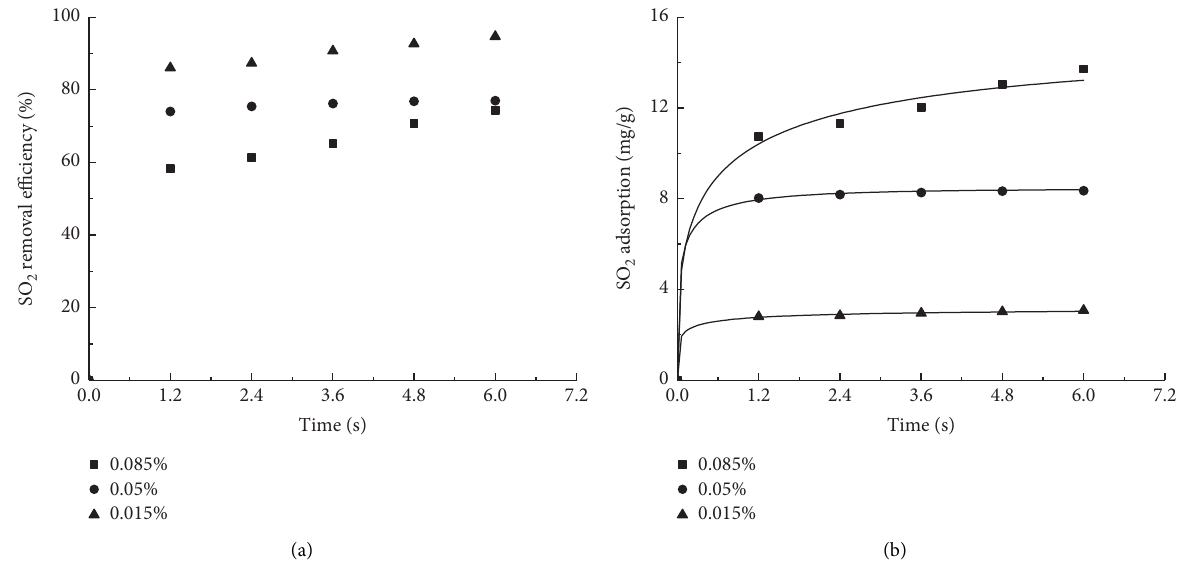
Figure 7: Influence of SO 2 concentration on (a) SO 2 removal rate and (b) SO 2